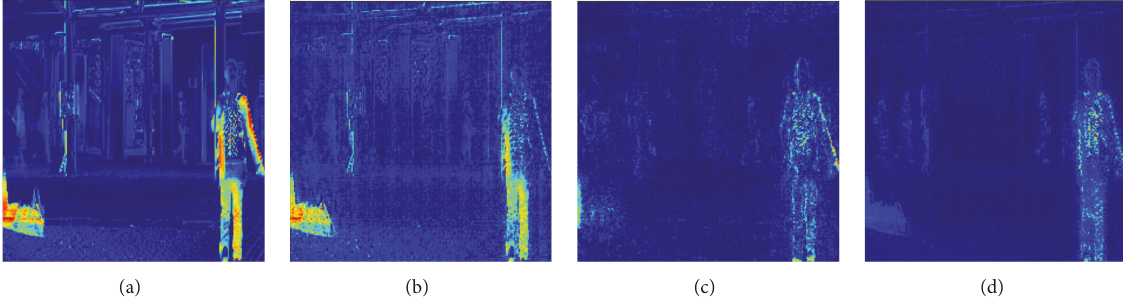
Figure 3: Illustration of pixel-level differences in the Avenue dataset: (a) input data, (b) pixel-level differences of ConvLSTM-AE, (c) pixel- level differences of Conv-AE, and (d) pixel-level differences of our approach.